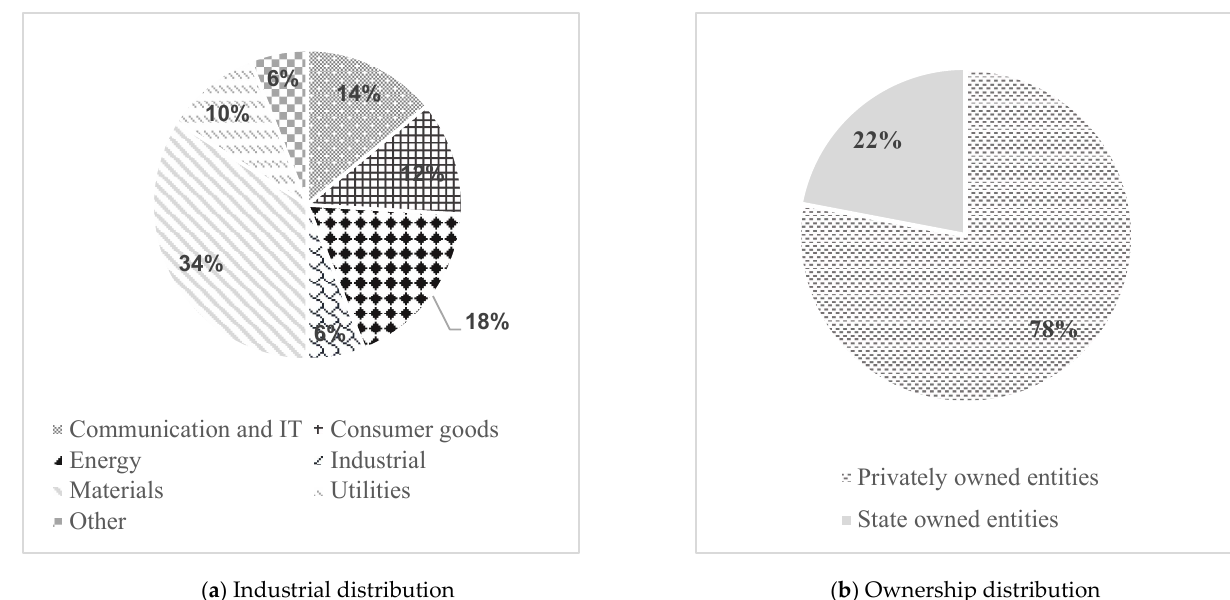
Figure 2. Characteristics of the sample: ( a ) industrial structure; ( b ) ownership type. Table 3. Descriptive statistics of data by EVA and other financial metrics.